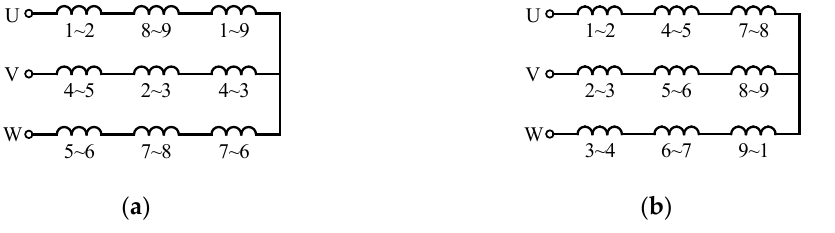
Figure 6. Winding connection. ( a ) For the fundamental component, 8-pole mode. ( b ) For the 3rd harmonic, 24-pole mode.